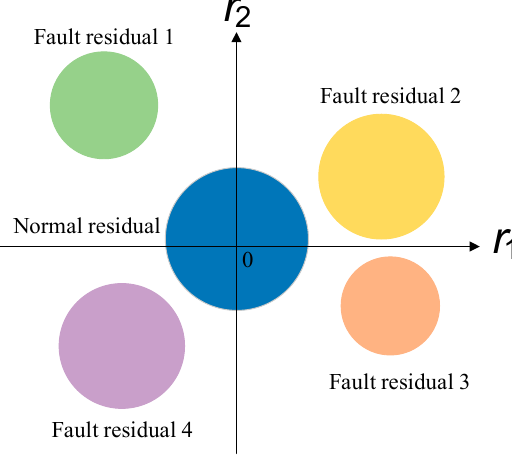
Figure 1. Residual distributions without measuring errors.